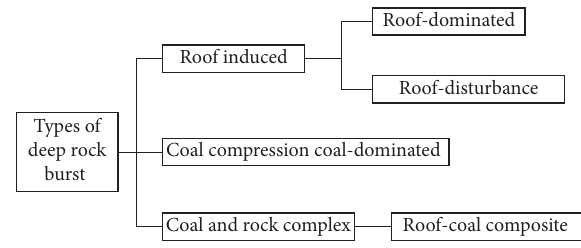
Figure 3: Types of deep rock